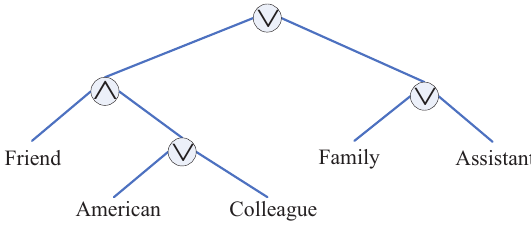
Figure 2. An example of the access